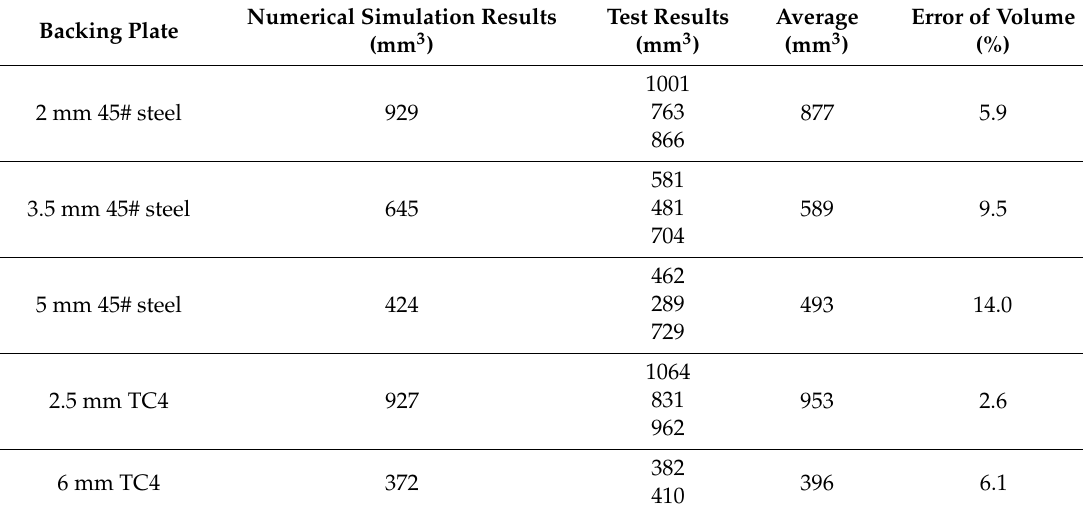
Table 3. Comparison between numerical simulation and experimental volume of penetration on a 2024 aluminum alloy witness plate under the penetration condition of 7.62 mm API and a 3-mm thick ceramic